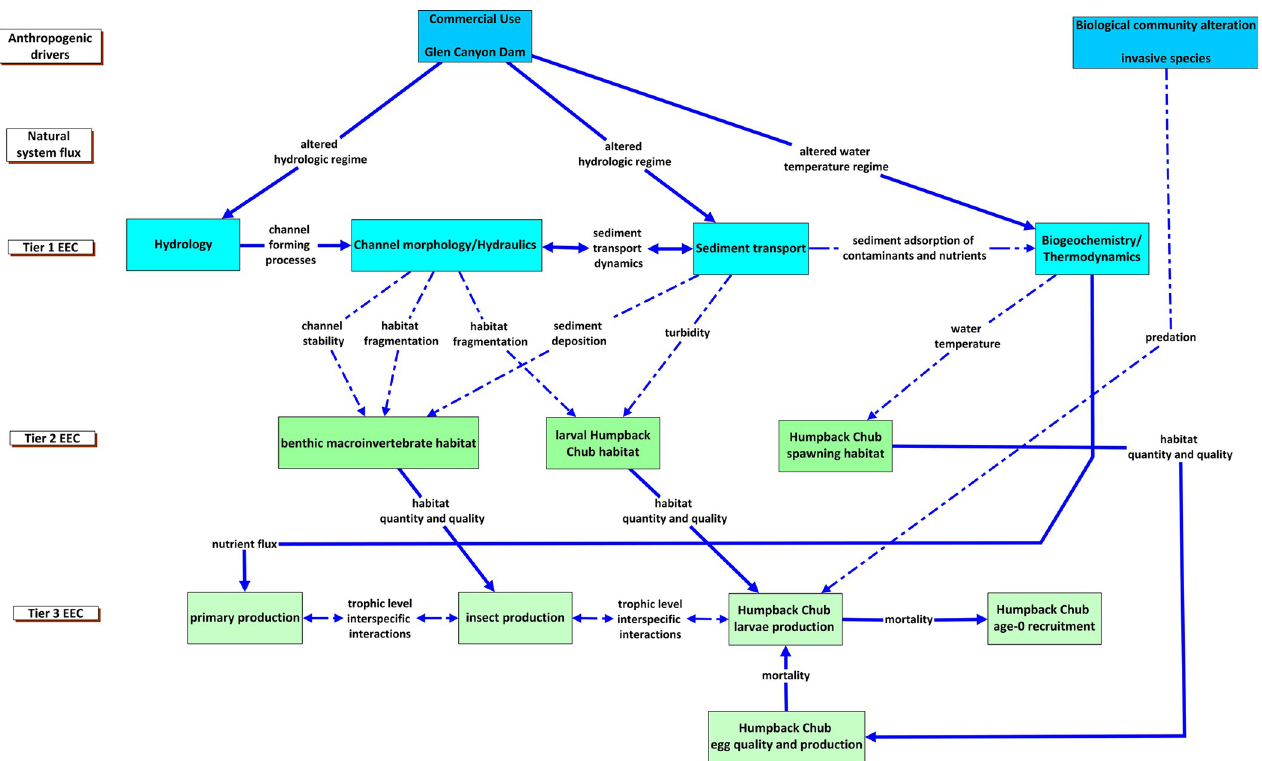
Fig 6. Conceptual model describing the relationship of anthropogenic drivers to essential ecosystem characteristics (EECs) affecting the recruitment of Humpback Chub in the Colorado River between Glen Canyon Dam and Lake Mead, Arizona. Essential ecosystem characteristics (EECs) are groupings of ecosystem components. Tier 1 EECs represent physical and chemical effects; fundamental measures of process that are directly affected by anthropogenic and natural drivers. Tier 2 EECs represent a broad habitat category that is intended to encompass the physical, chemical, and biological components of the riverine habitats that influence reproduction, growth, and survival of biotic communities. The Tier 3 EECs represent components of the biological systems that respond to changes in the hierarchical components of the conceptual model. The strength of our understanding of how natural and anthropogenic drivers interact with habitats, biological systems, and fish in large rivers is represented by the different types of lines in the figure. Solid blue lines depict a strong understanding of the relationship, the dotted-dashed blue line represents a moderate understanding of the relationship, and the black dashed line represents a weak understanding of the relationship. The different types of lines also represent the strength of our understanding of within EEC-tier relationships.